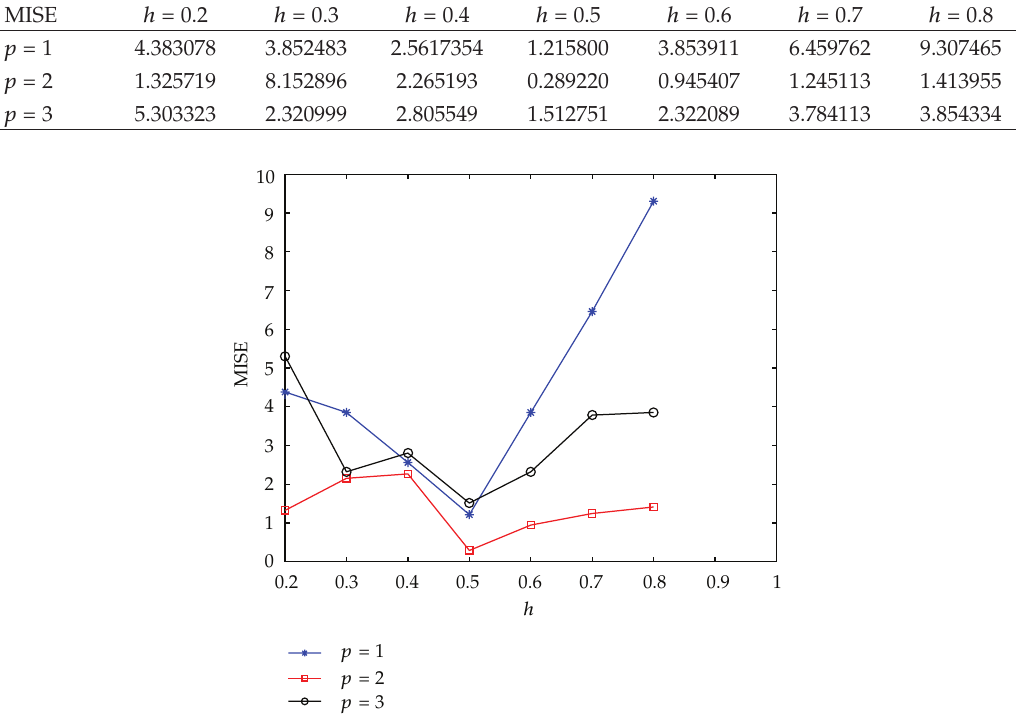
Figure 1: The scatter plot under di ff erent